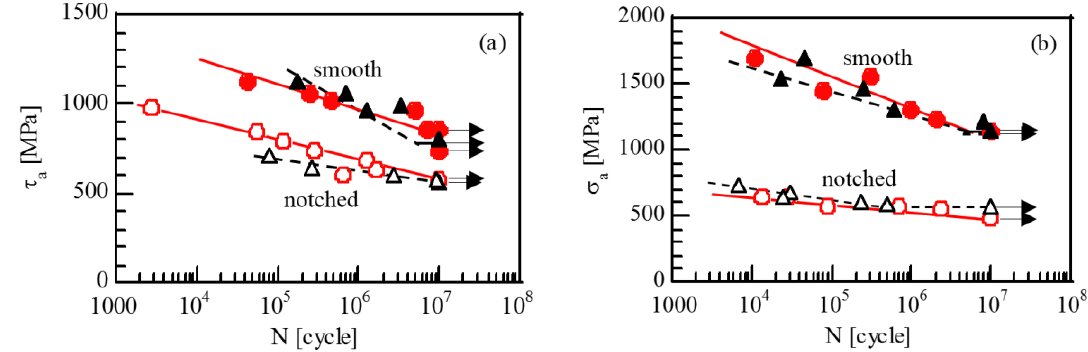
Figure 6. ( a ) Nominal shear stress amplitude ( τ a ) and ( b ) bending stress amplitude ( σ a )—number of cycles ( N ) curves of smooth and notched specimens in TM (● ○ ) and SNCM420 ( ▲ △ ) steels subjected to vacuum carburizing and subsequent fine particle peening. Table 4. Numbers of cycles to fracture ( N f [cycle]) in vacuum-carburized and subsequently fine particle peened TM and SNCM420 steels tested at various ( a ) nominal shear stress amplitudes ( a